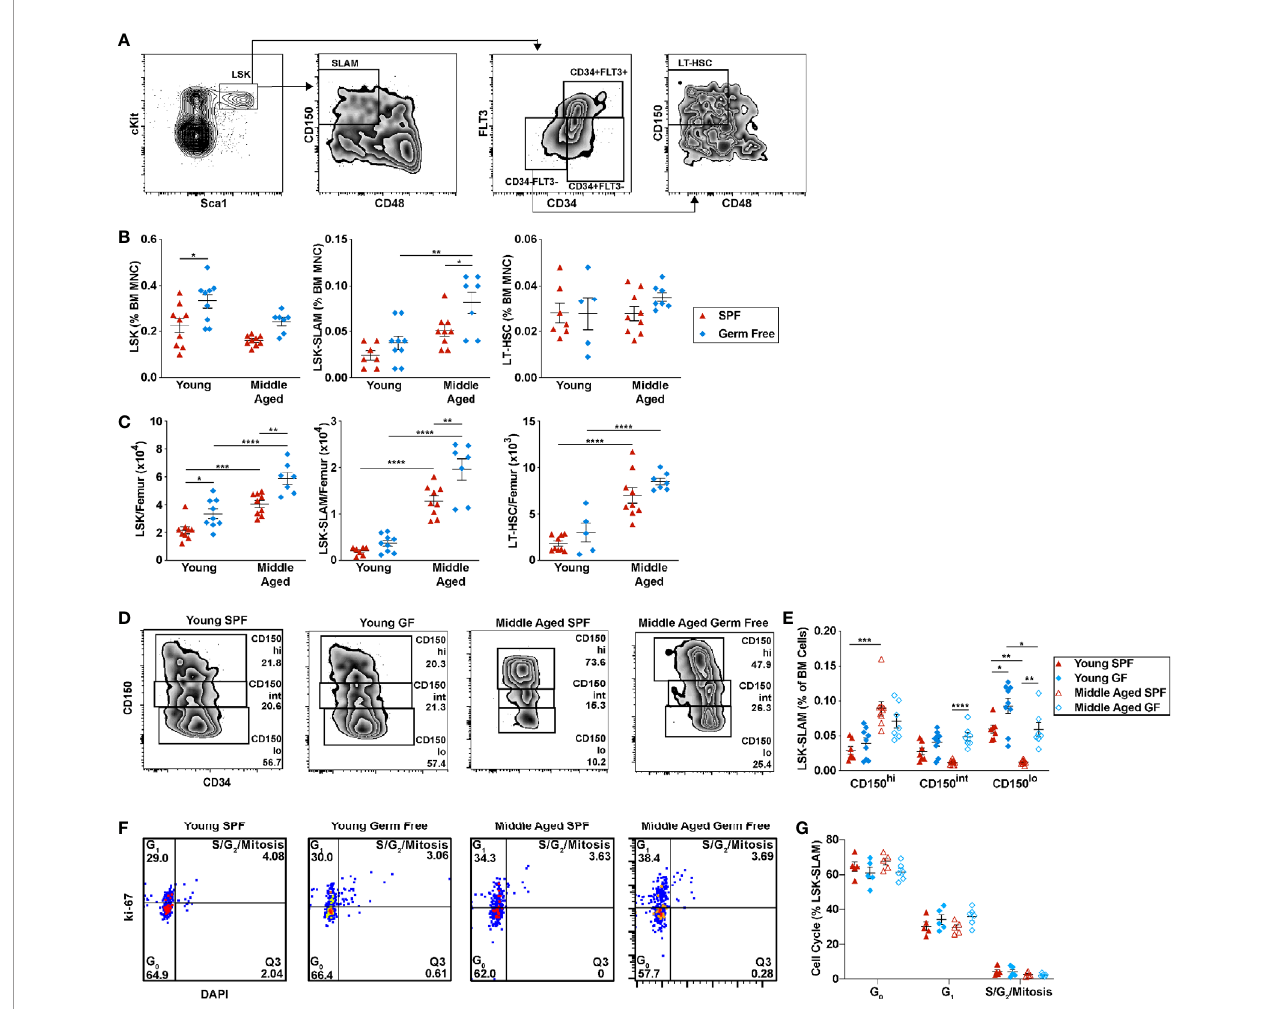
FIGURE 3 | Microbiota signals are not required for the expansion of HSCs with aging. (A) Representative fl ow plots of young SPF mouse BM showing the gating strategy used to identify LSK, LSK-SLAM, and LSK-SLAM CD34- (LT-HSC) cells. (B) Percent and (C) number of LSK, LSK-SLAM, and LSK-SLAM CD34 - cells (LT- HSC) per femur. (D) Representative fl ow plots showing the frequency of CD150 hi , CD150 int , and CD150 lo HSCs; data are gated on LSK cells. CD150 gating for each experiment was adjusted based on FMO controls. (E) Frequency of CD150 hi , CD150 int , and CD150 lo HSCs. (F) Representative fl ow plots showing the gating strategy used to identify cell cycle status of LSK-SLAM cells. (G) Cell cycle distribution of LSK-SLAM cells. Data represent the mean ± SEM. *P < 0.05, **P < 0.01, ***P < 0.001, and ****P < 0.0001 by one-way ANOVA with alpha = 0.05 and Sidak ’ s multiple comparisons